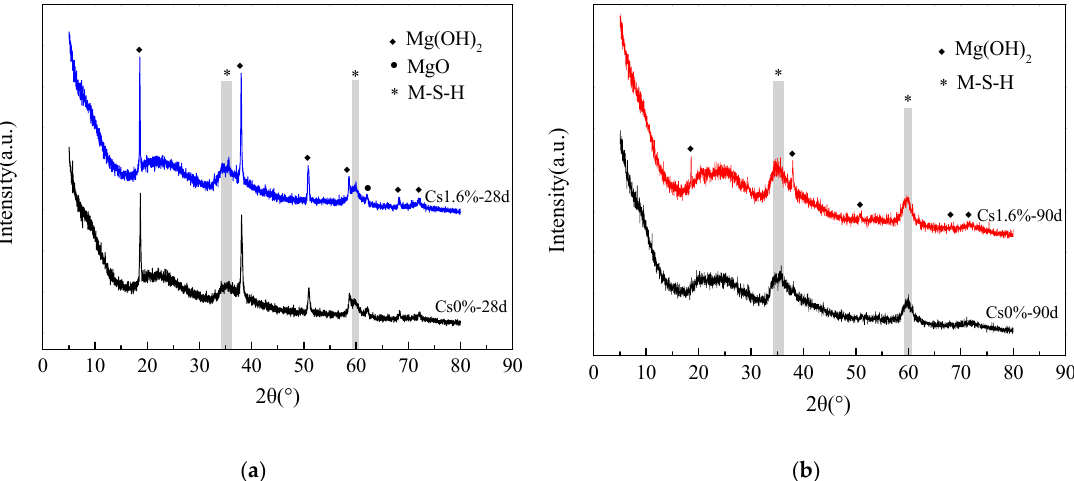
Figure 4. X-ray diffraction data of the M–S–H cement-solidified body with 1.6 wt % Cs + and without Cs + after ( a ) 28 and ( b ) 90 d.